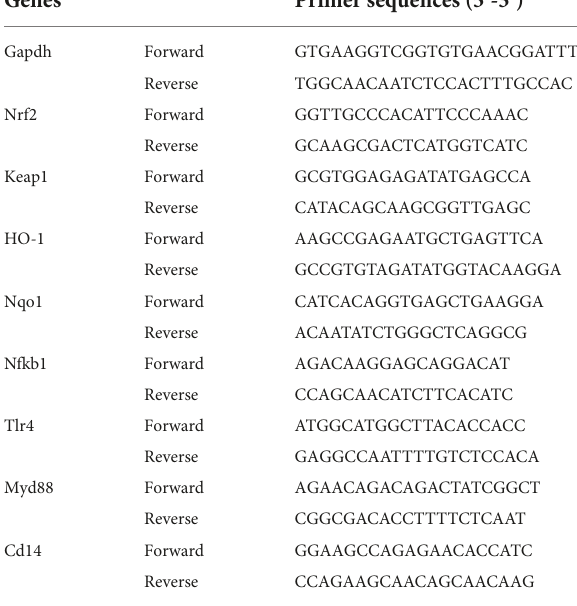
TABLE 1 Primer sequences used for RT-qPCR. Genes Primer sequences (5 (cid:48) -3 (cid:48)